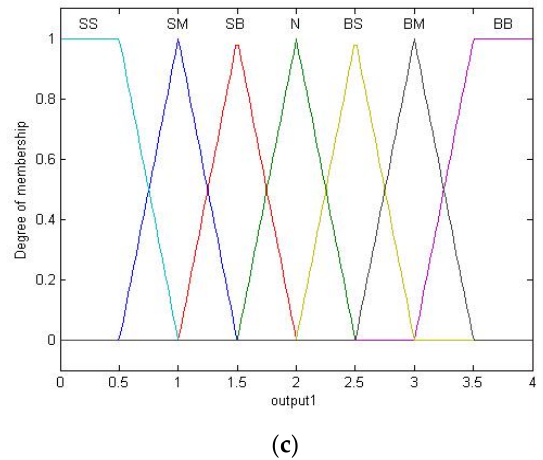
Figure 8. (a) Degree of membership error (input), ( b ) Degree of membership delta error (Input) and ( c ) . Degree of Membership (Output).